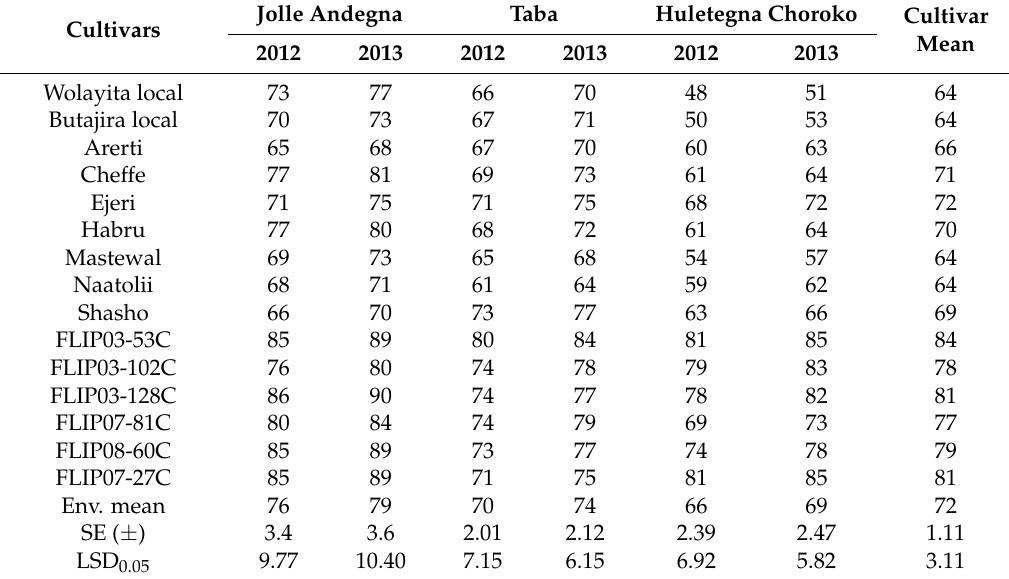
Table 2. Plant height (cm) of 15 chickpea cultivars and breeding lines tested under zinc fertilized soil across three locations in southern Ethiopia during the 2012 and 2013 growing seasons.